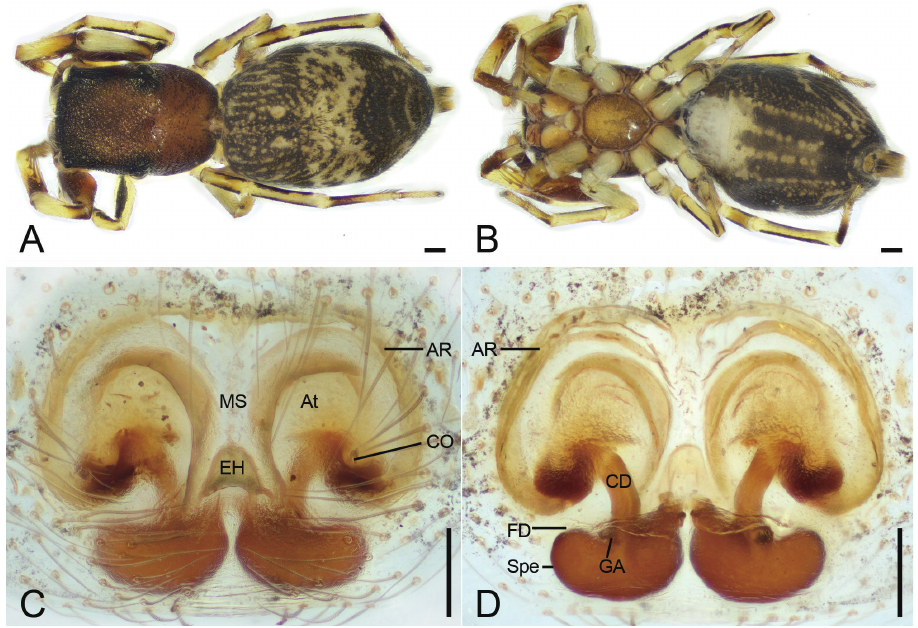
Figure 3. Synagelides emangou sp. nov., female paratype A habitus, dorsal view B same, ventral view C epigyne, ventral view D same, dorsal view. Abbreviations: AR – atrial rim, At – atrium, CD – copula- tory duct, CO – copulatory opening, EH – epigynal hood, FD – fertilization duct, GA – glandular ap- pendages, MS – median septum, Spe – spermatheca. Scale bars: 0.2 mm ( A, B ); 0.05 mm ( C, D